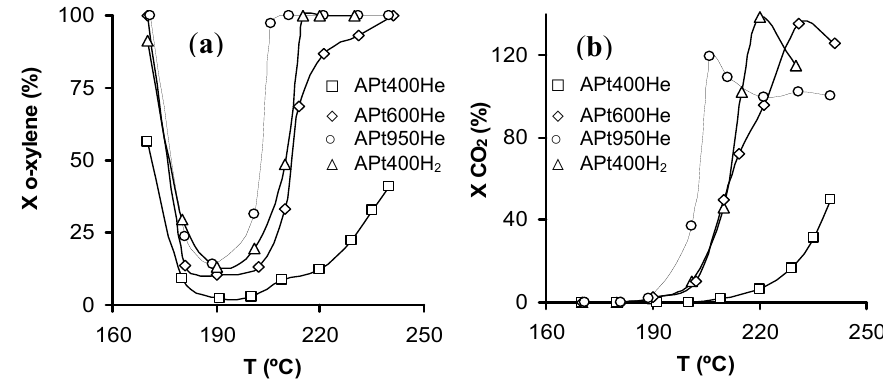
Figure 11. Light-off curves for the supported Pt catalysts: ( a ) conversion of o -xylene and ( b ) conversion to CO 2 ([ o- xylene] = 0.10 vol.%, Q = 3.6 L h − 1 , 0.10 g catalyst ). Figures reprinted with permission from [67]. Copyright 2005, Elsevier.